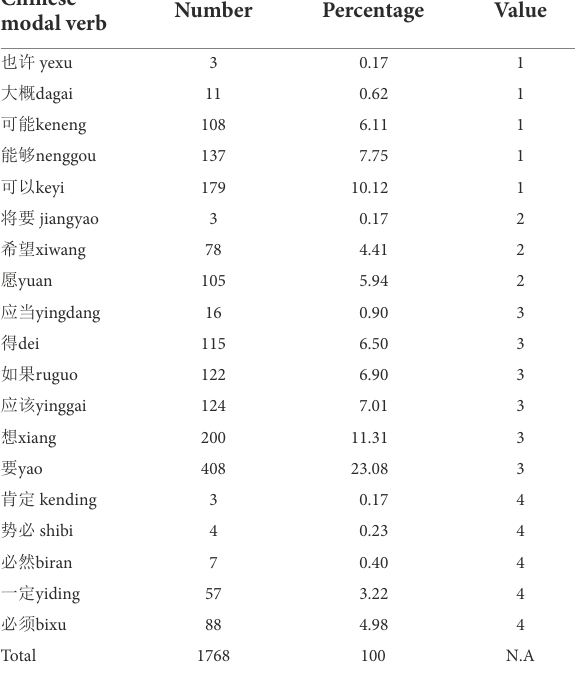
TABLE 4 Distribution of Chinese modal verbs. Chinese modal verb